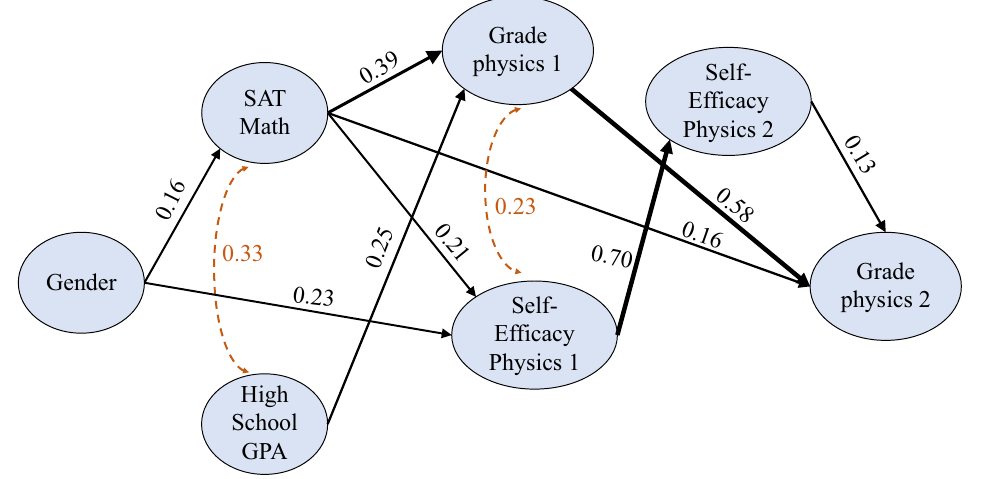
FIG. 2. Result of the path analysis part of the SEM between gender and physics 2 grade through students ’ self-efficacy for model 1. The line thickness indicates the relative magnitude of β values. The dashed lines indicate covariances between constructs. All p values are p < 0 . 001 . Gender does not directly predict the physics grade.